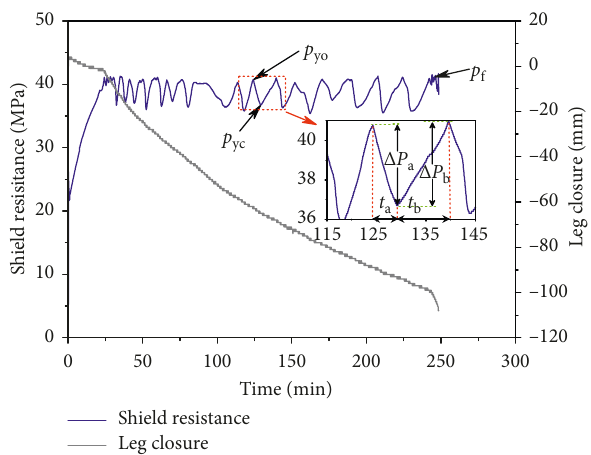
Figure 3: Temporal evolution of shield resistance and leg closure in a typical shield-supporting cycle with continuous yielding. Nega- tive leg closure means the shortening of shield